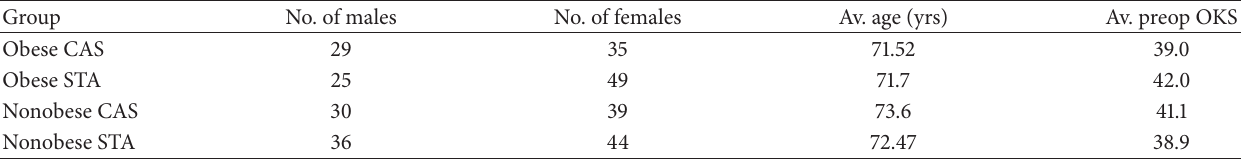
Table 1: Sex distribution and average age in groups.